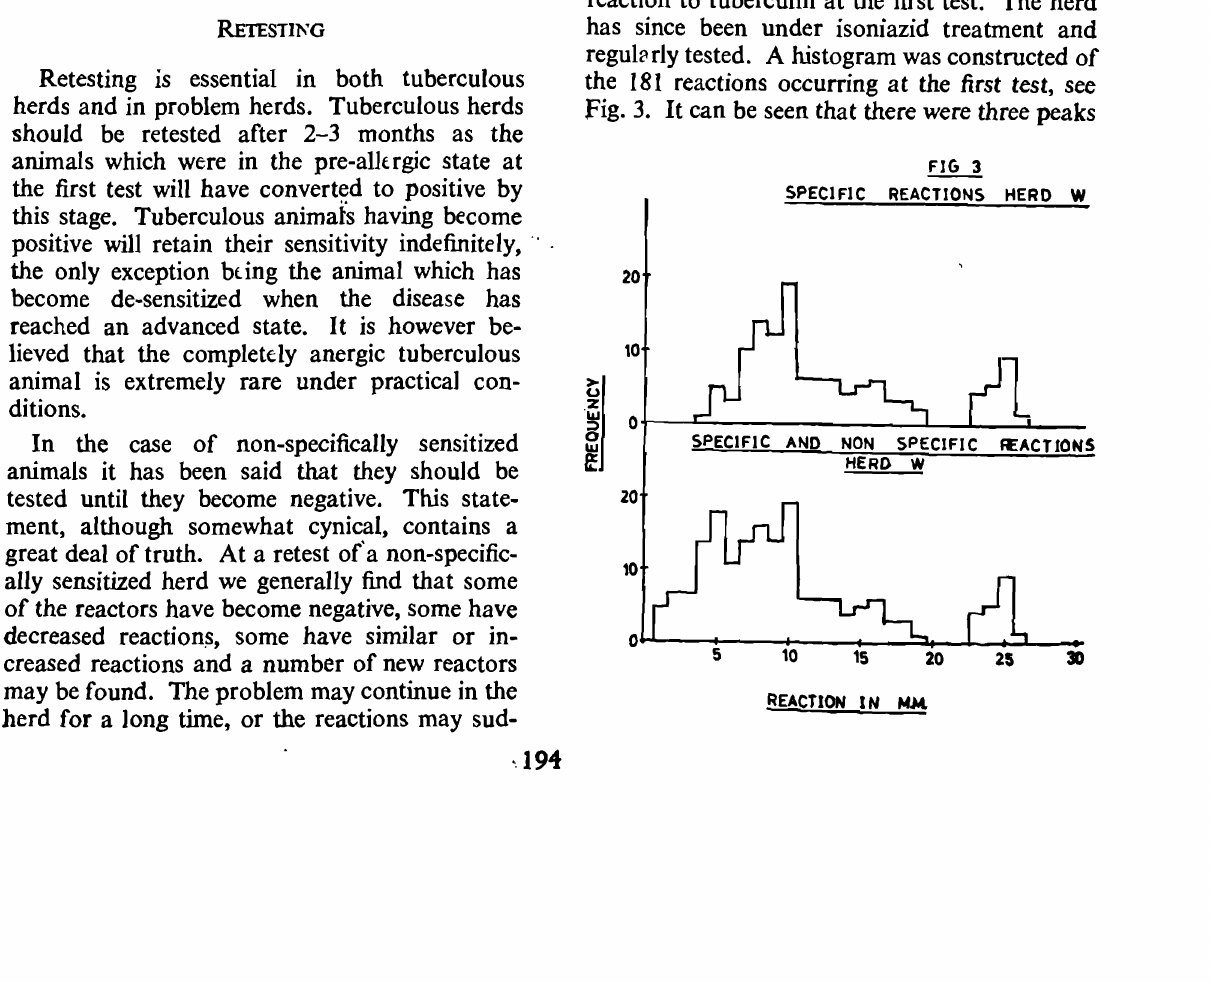
FIG 3 SPECIFIC REACTIONS HERD